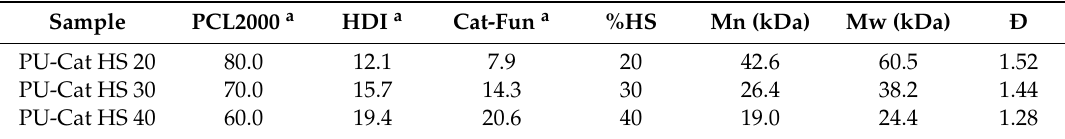
Table 1. Weight fractions of synthetized polyurethanes bearing catechol motifs and their molecular weight.